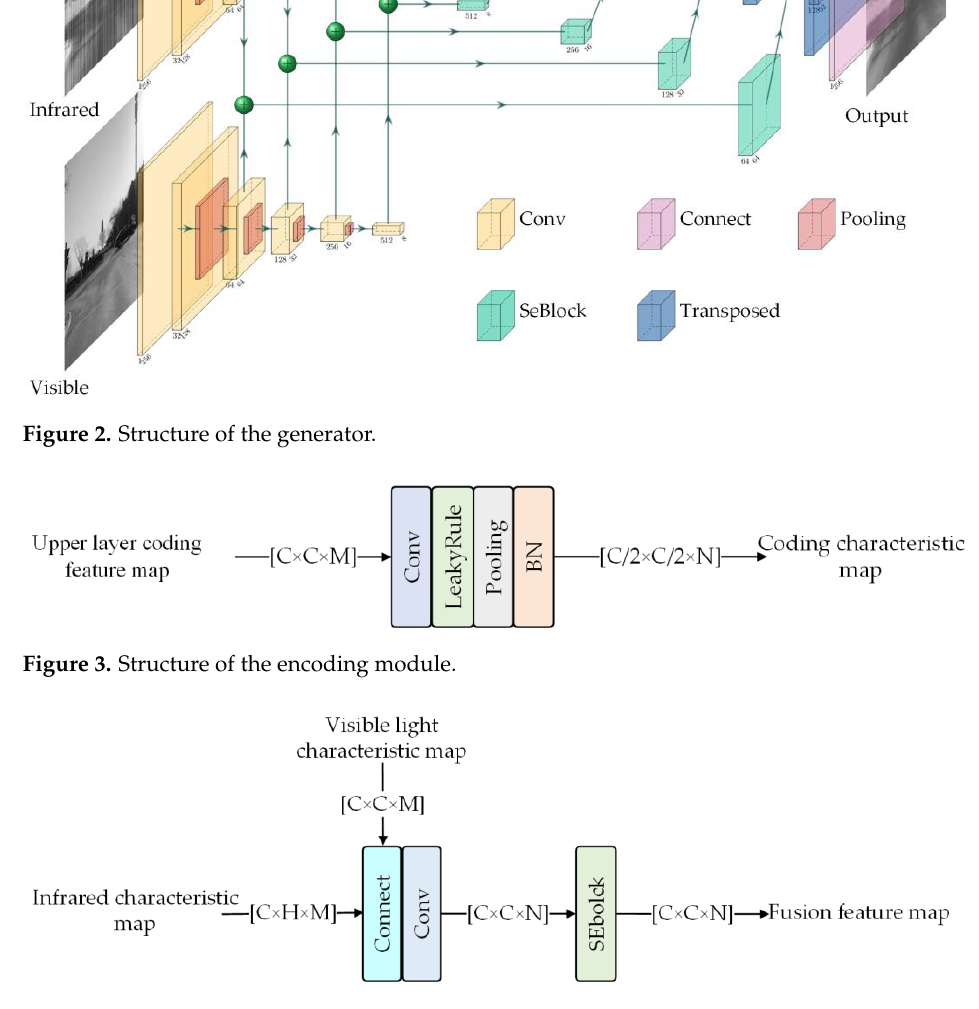
Figure 4. Feature fusion module.